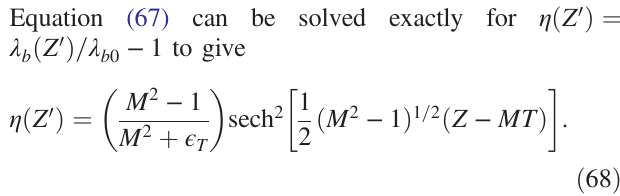
FIG. 8. Plots of (a) V ð η Þ versus η ; and (b) η ð Z 0 Þ versus Z 0 , obtained from Eqs. (56) and (62) for M 2 ¼ 4 , ϵ E ¼ 0 , corresponding to soliton amplitudes η þ ¼ 1 . 735 .